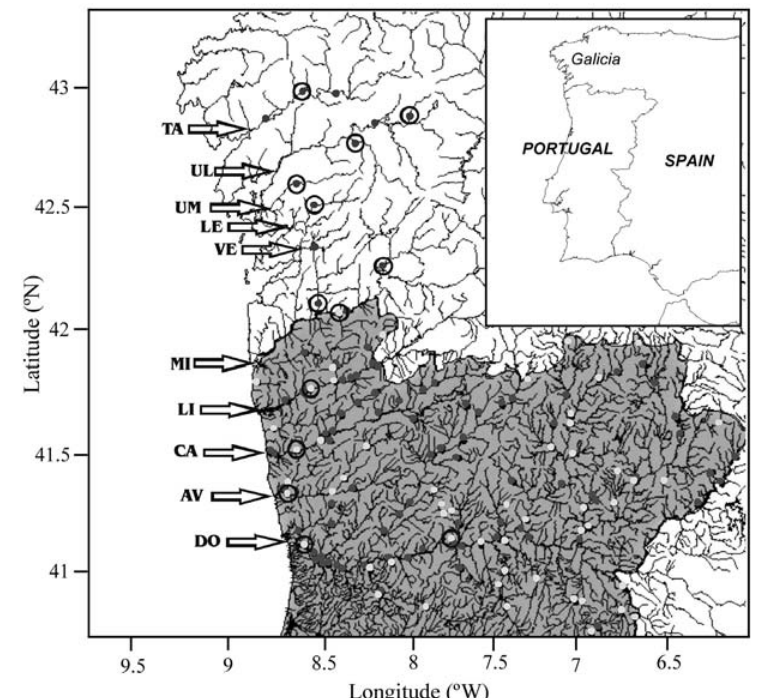
Fig . 1. – Map with all gauging stations in the study region. The gray area is Portugal and the white area is Spain. In the Portuguese region, gray dots indicate conventional recording of data, whereas the white ones indicate automatic recording of data. Black circles show the selected stations in this study. The river mouths are indicated with the first two letters of their names: TA (River Tambre), UL (River Ulla), UM (River Umia), LE (River Lérez), VE (River Verdugo), MI (River Miño), LI (River Lima), CA (River Cávado), AV (River Ave) and DO (River